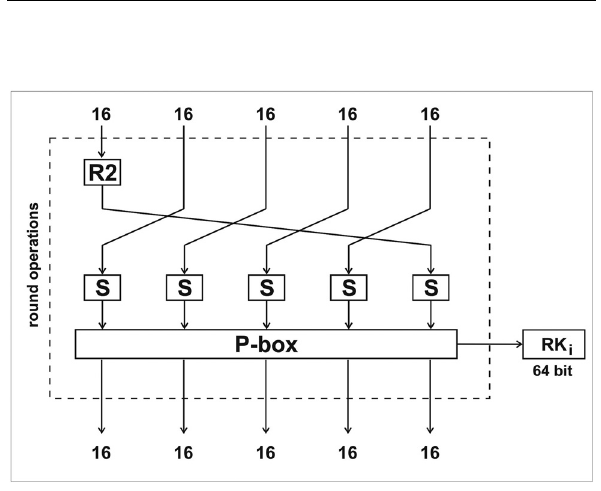
Figure 2: Scheme for generating round keys of the LBC - 3